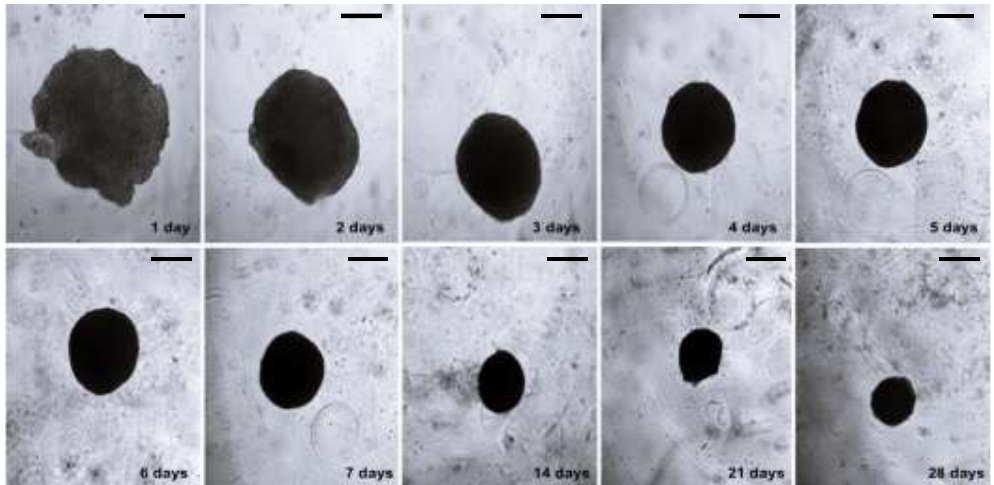
Figure 1. Representative images by optical microscopy of MC3T3-E1 spheroids of 20,000 cells during the first 7 days and at the 14th, 21st, and 28th days of formation. Images obtained with a 20 × objective. Scale bars indicate 100 µ m.